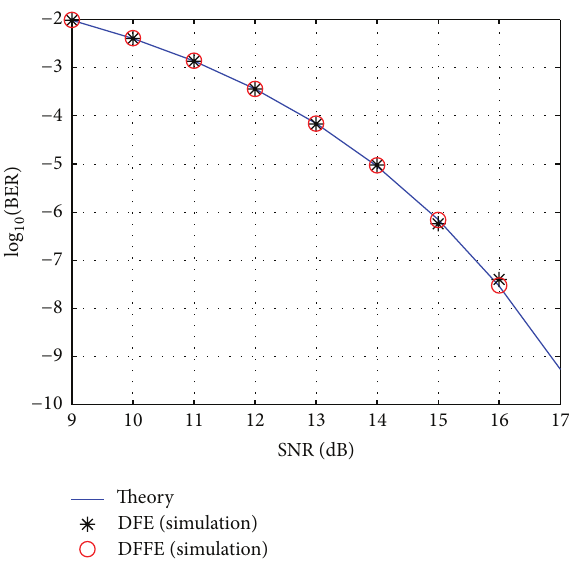
Figure 4: Performance of DFFE with 𝑅 = 7 and DFE. Postcursor channel with 𝛼 = 0.5/𝐿 = 6 .